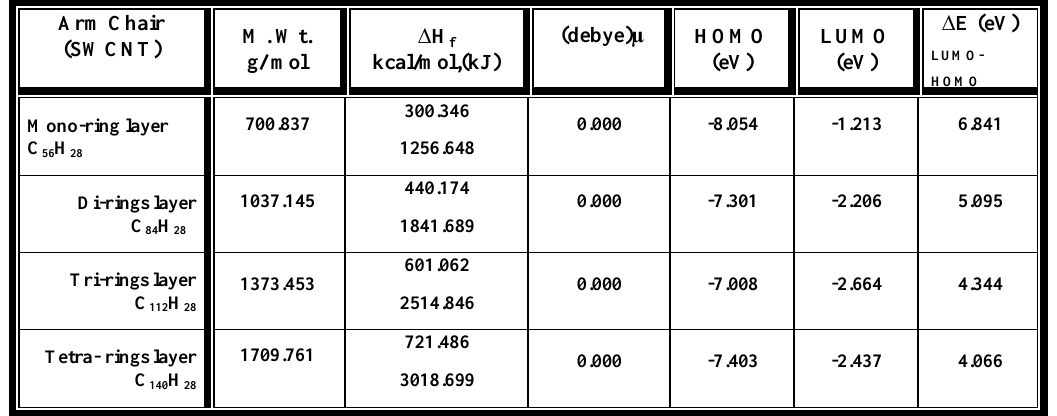
Table 2: Some physical properties of the calculated (mono, di, tri and tetra) rings layer for (7,7) armchair SWCNT at their equilibrium geometry by using Mopac2000